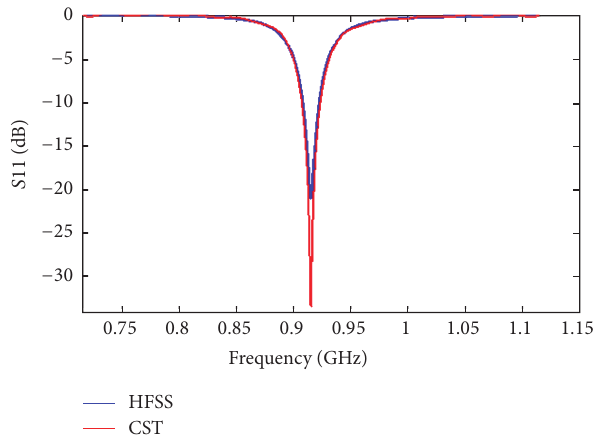
Figure 9: Return loss 𝑆11 of the 3D spherical antenna (Table 4).